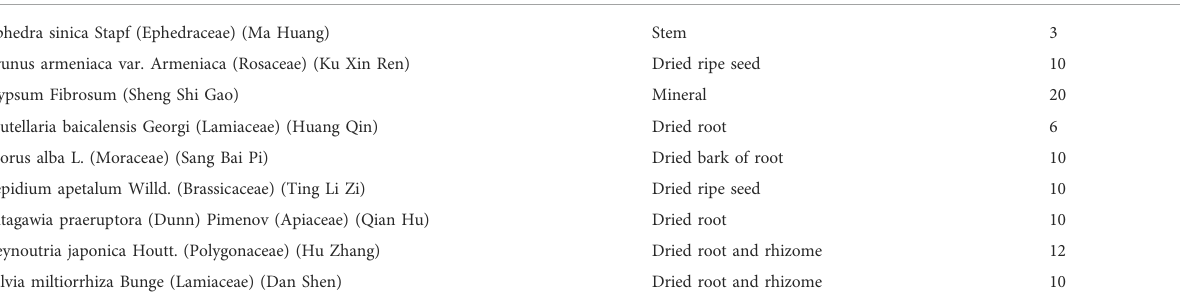
TABLE 1 Composition of Qingfei oral liquid